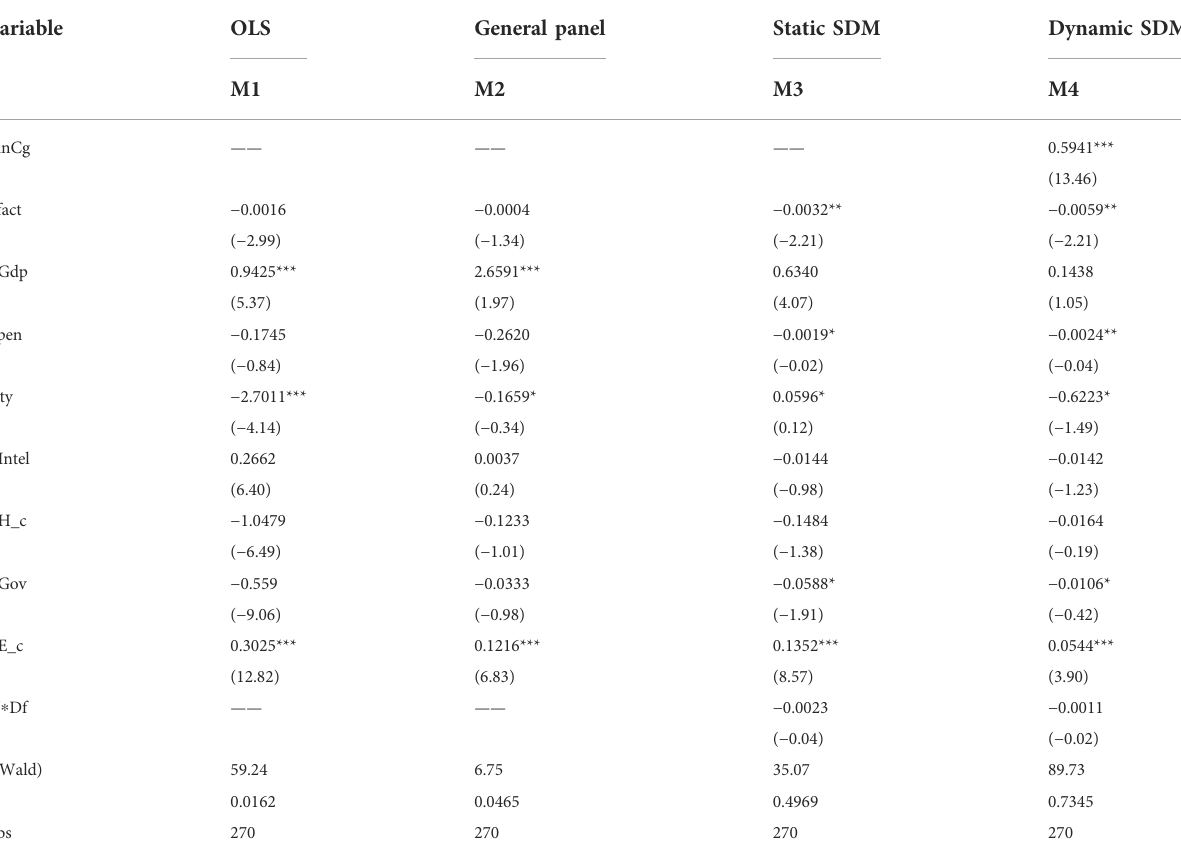
TABLE 3 Benchmark regression